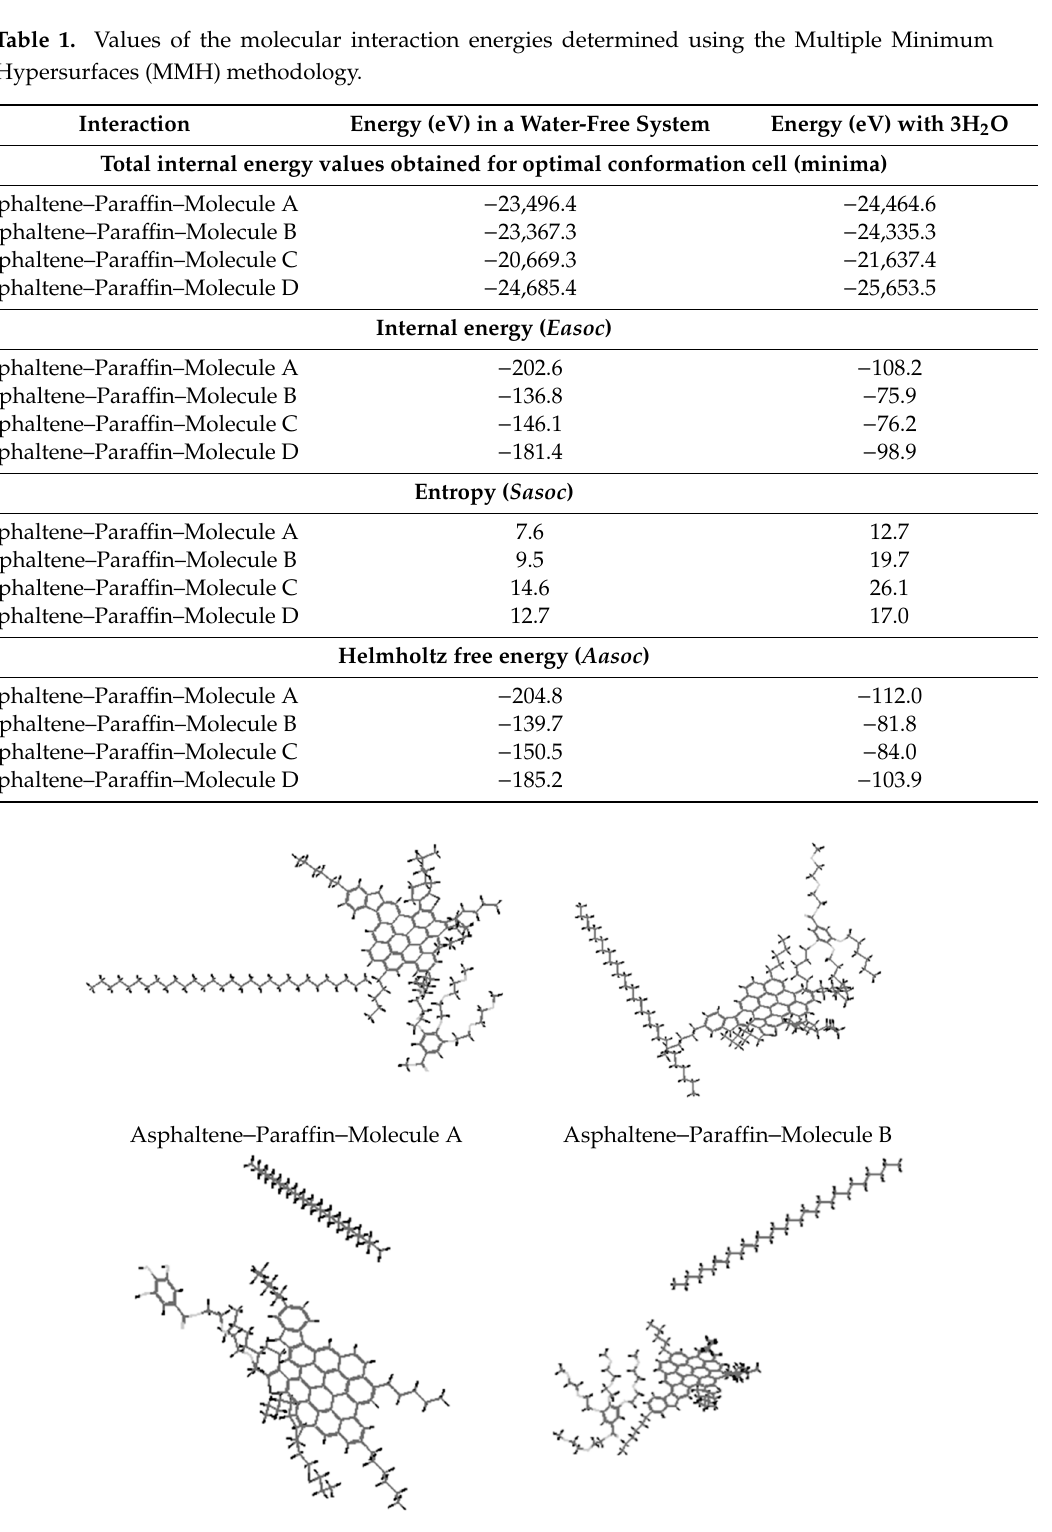
Figure 2. Free-water conglomerate interactions.